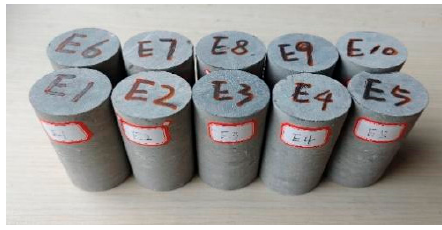
Figure 1. Limestone specimens.